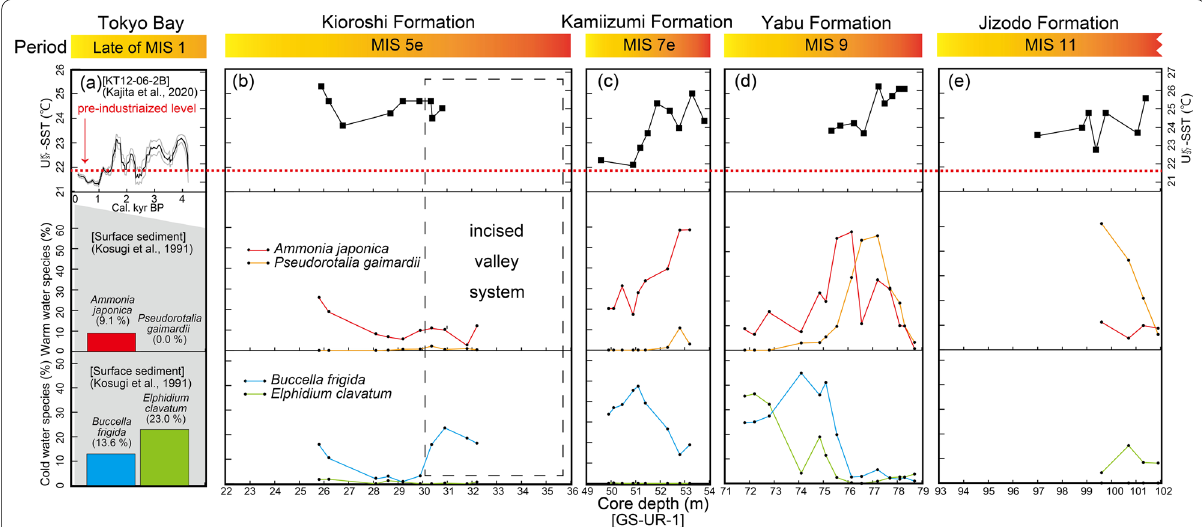
Fig. 6 Variations of U K ′ 37 -SST and the abundance of benthic foraminifer in the present-day Tokyo Bay and Palaeo-Tokyo Bays. The left and right axes show the calculation results after performing culture calibration (Sawada et al. 1996) and global core-top calibration (Müller et al. 1998), respectively. a Variation of U K ′ 37 -SSTs in Tokyo Bay over the past 4200 years (late of MIS 1) recovered from the sediment core KT12-06-2B (Kajita et al. 2020b). The 11 points’ running average (black line) with standard error ranges (grey lines) is presented. The pre-industrial level obtained by averaging the values from 1850 to 1950 CE is shown by the red dotted line. The benthic foraminiferal assemblage in the surface sediment is at almost the same location as the site of the KT12-06-2B core (K5 site in Kosugi et al. 1991). b – e Variations of U K ′ 37 -SSTs (this study) and benthic foraminiferal abundances in Palaeo-Tokyo Bays (Kaneko et al.